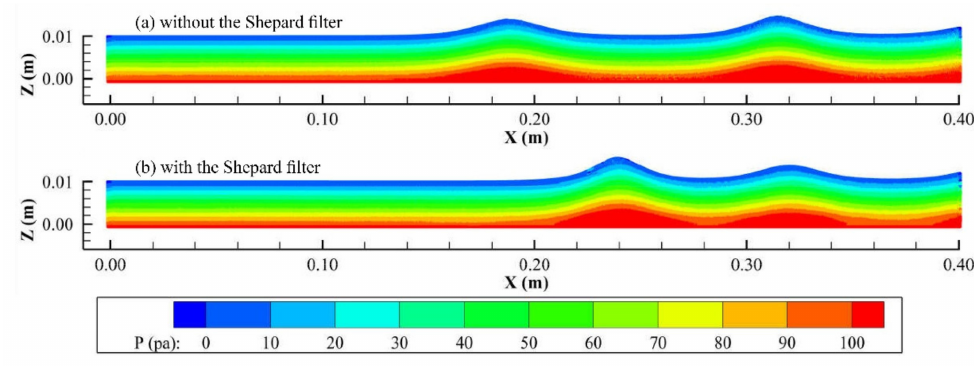
Figure 8. Pressure fields of case 1 at t = 15.96 s.